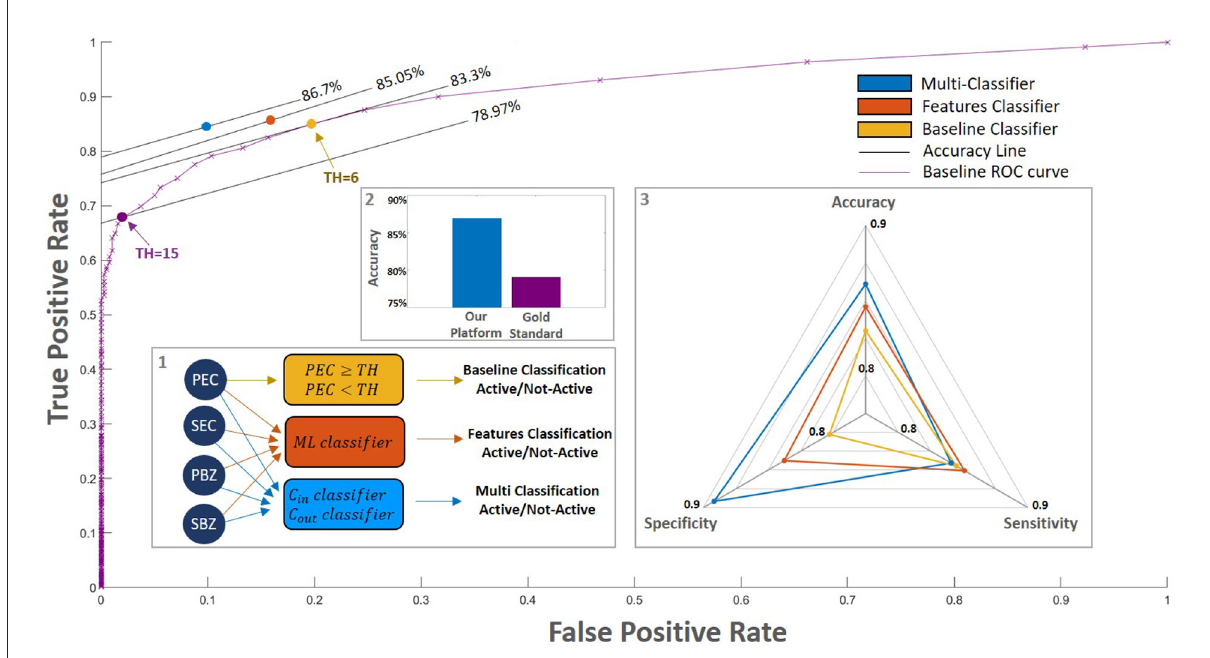
FIGURE5 Classification performance of the different models. (inset 1) We examined a few different classification approaches: 1. A baseline in which the classification is according only to the PEC (yellow rectangle, purple curve). The purple line outlines this model’s performances for different thresholds. On this purple curve, the purple circle denotes the gold standard threshold of PEC = 15 and the yellow circle denotes the optimal baseline threshold of PEC = 6; 2. A trained classifier that accounts for all four WSI scores (orange rectangle, orange circle); 3. Our platform: a multi-classification approach that separates patients close to the decision threshold from those that are far from it (blue rectangle, blue circle); (inset 2) The accuracy of our platform compared with those of the gold standard. (inset 3) Spider plot depicts the performance of the different models. Our platform which accounts for all the AI WSI scores significantly improves the overall classification